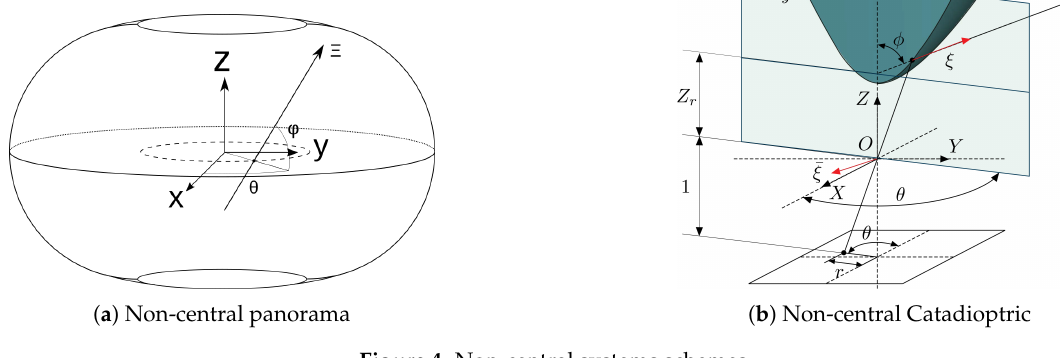
Figure 4. Non-central systems